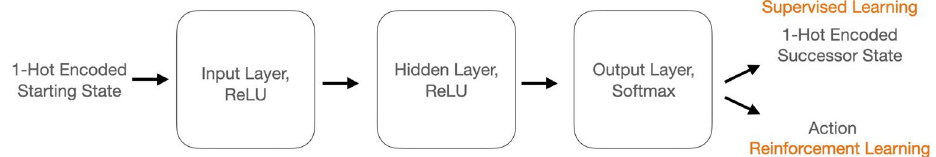
Figure 1. A scheme of the used Neural Network for the supervised and reinforcement learning task. The network receives the one hot encoded starting state of the environment as input. It uses one hidden layer with a ReLU activation function and the output is a softmax layer. In the case of the spatial exploration and the linguistic task, the output of the network is the one-hot encoded successor state of the corresponding input. In case of the spatial navigation task, which uses reinforcement learning, the output of the network is the action depending on the input